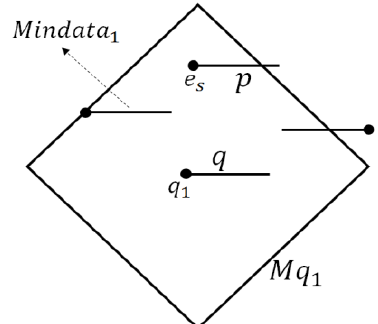
Figure 5. Suitable placement of uncertain points mentioned in proof of lemma 1.